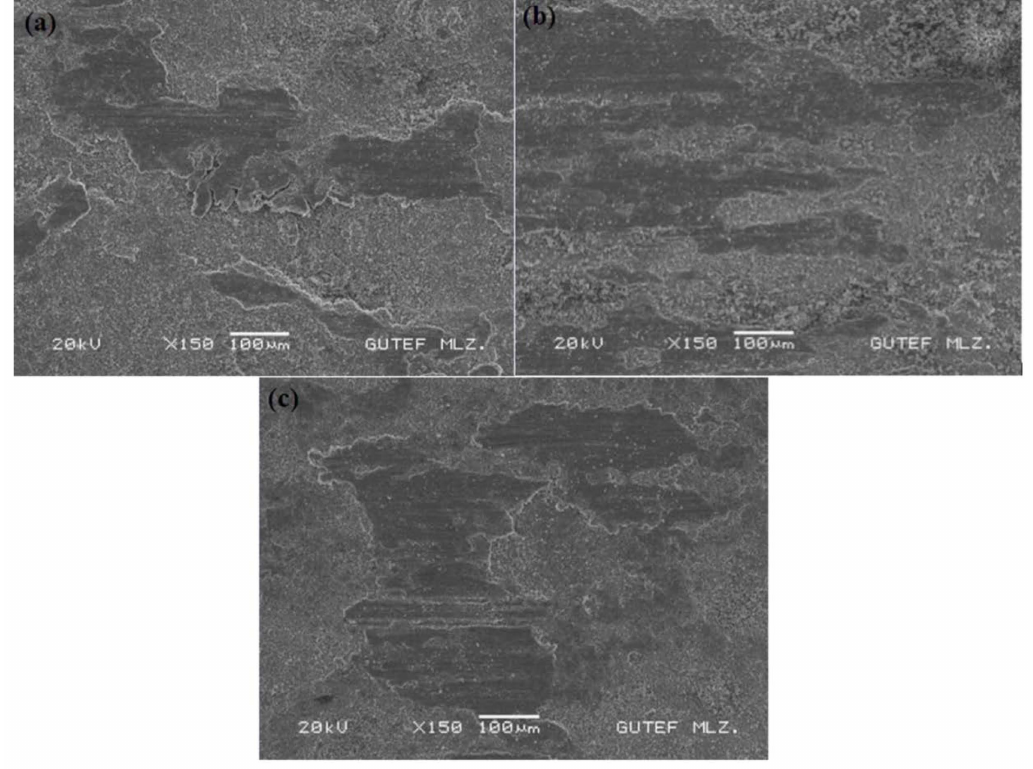
Figure 8. SEM images of the worn surface of Al-Ti alloys 4% Ti ( a ); 6% Ti ( b ); and 8% Ti ( c